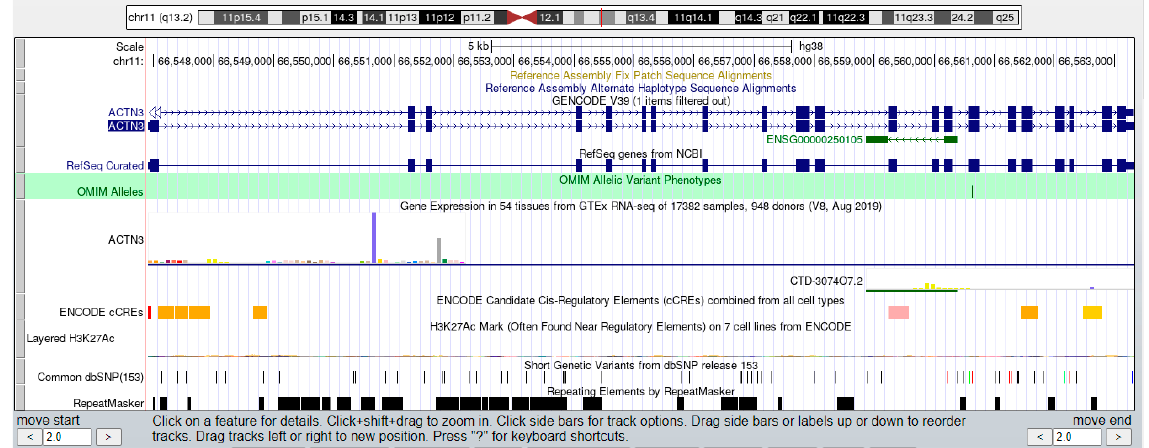
Figure 4. ACTN3 is linked to UCSC. Click the content in Chr to link to the UCSC genome browser, as shown in the figure. Here, it shows a fragment of chromosome 11 ranging from 66,082,191 to 66,092,191.